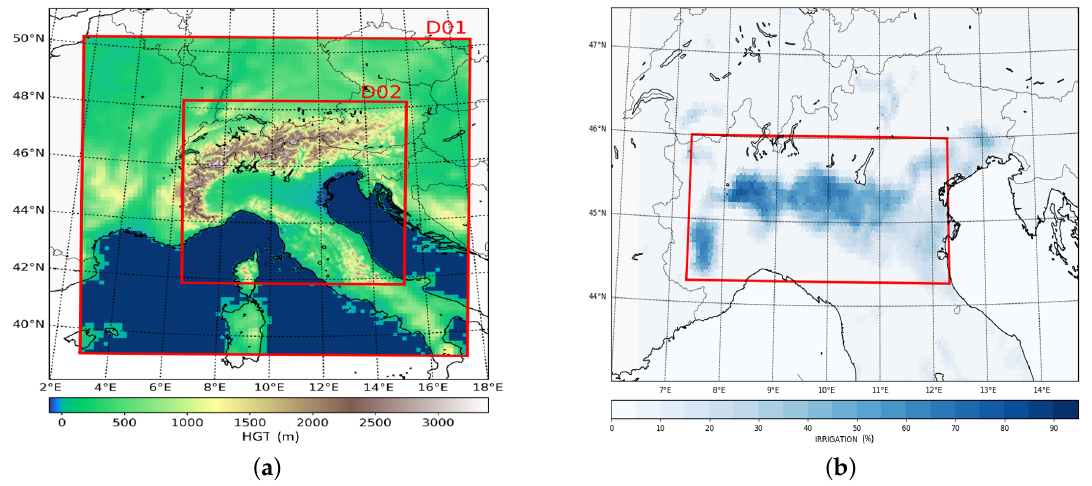
Figure 1. Study area model specifics: Position and irrigated area as a percentage of the grid point. ( a ) Outer (D01) with 15 km grid resolution, and the inner (D02) with 3 km. ( b ) Percentage of irrigated area after regridding for the Po Valley. The red box highlights the averaging area used in this